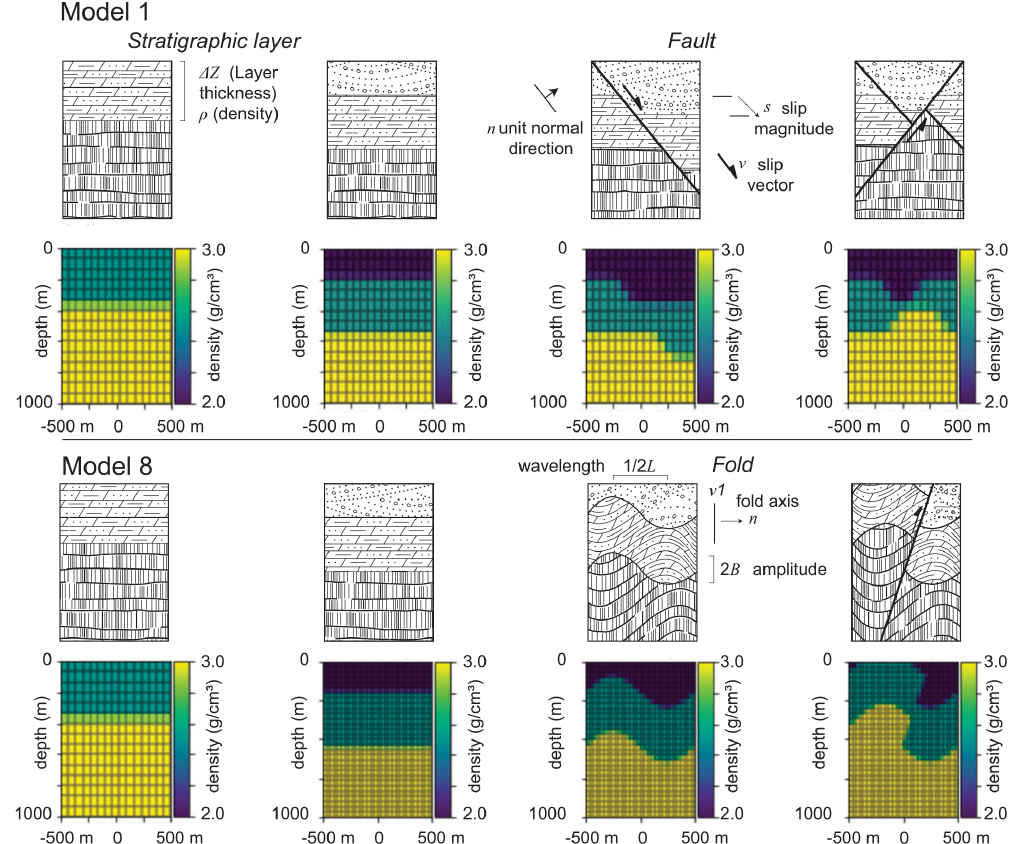
Figure 4. Calculation of forward geology for Models 1 and 8 through a sequence of tectonic events: the addition of two stratigraphic layers and two faults. Top: geology; bottom: anti-aliased, voxelized